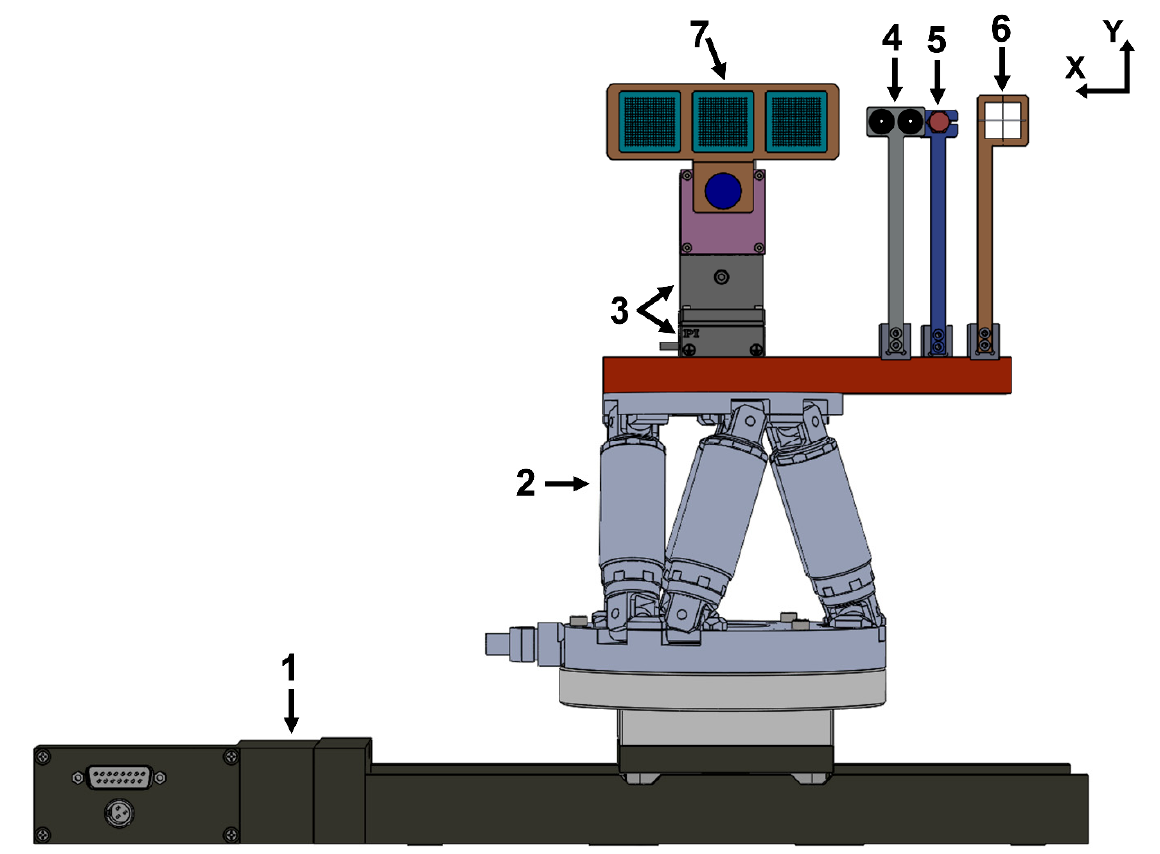
Figure 3. A schematic view of the sample stage with components marked by numbers. (1) Long stroke translation stage; (2) hexapod holding; (3) high-speed piezo XZ stages for raster scanning; (4) pinholes with 100 µm diameter; (5) ultrafast photodetector for checking temporal overlap of pump and probe sources; and (6) 200-µm thick tungsten wire for measuring focused X-ray beam size. (7) Membrane holders and three membranes can be mounted at once.